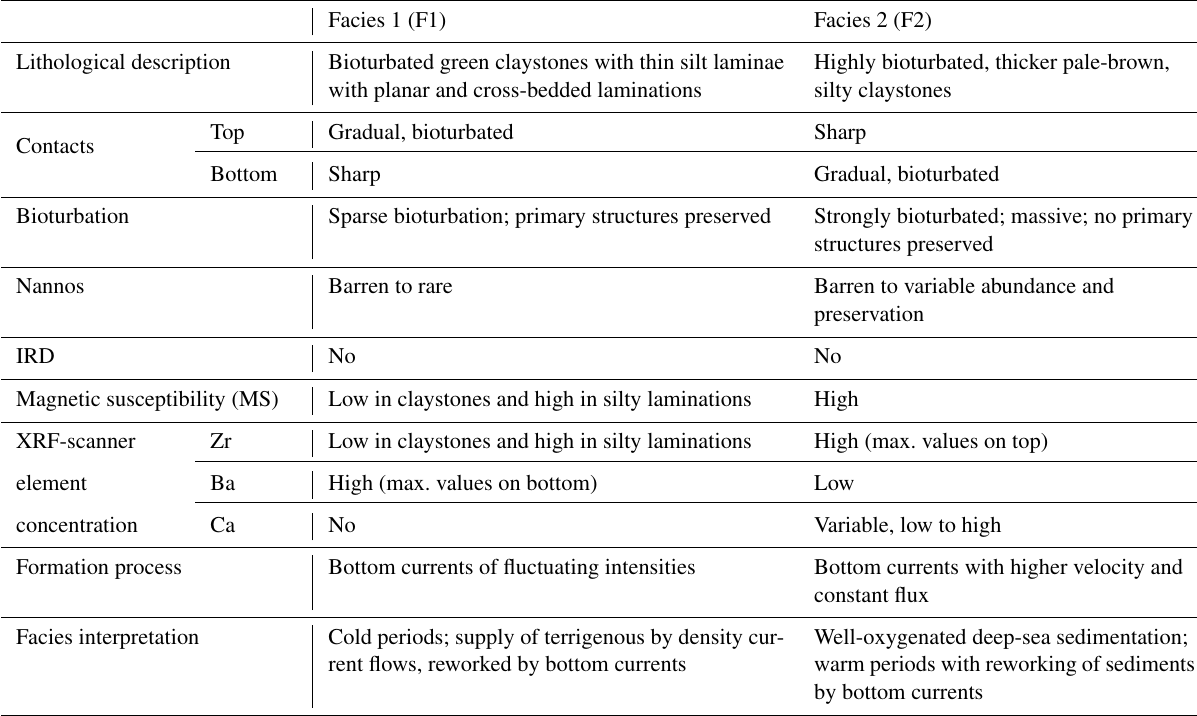
Table 2. Types of facies differentiated by physical, geochemical, and biological character and their interpretation in terms of sedimentary processes and